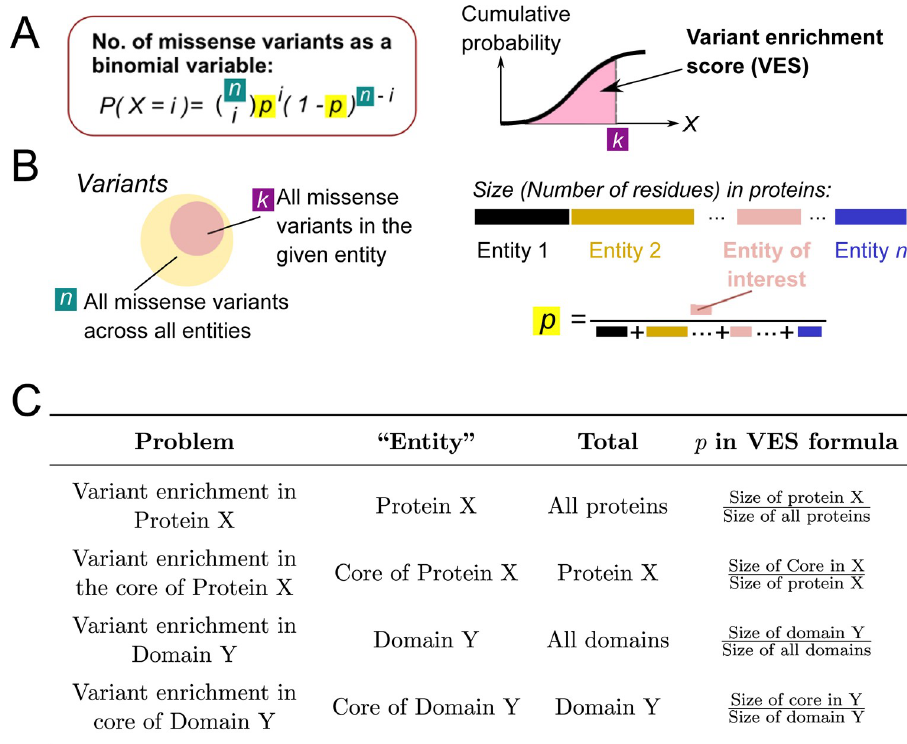
Fig 9. Illustration of missense variant enrichment calculation. (A) The number of missense variants is modelled as a binomial variable. The cumulative distributive function of this binomial variable is taken as a VES for the level examined. (B) Illustration of the choice of parameter in defining the binomial variable used in calculating the VES. (C) Examples of defining the parameter p in quantifying variant enrichment for different cases. VES, Variant Enrichment